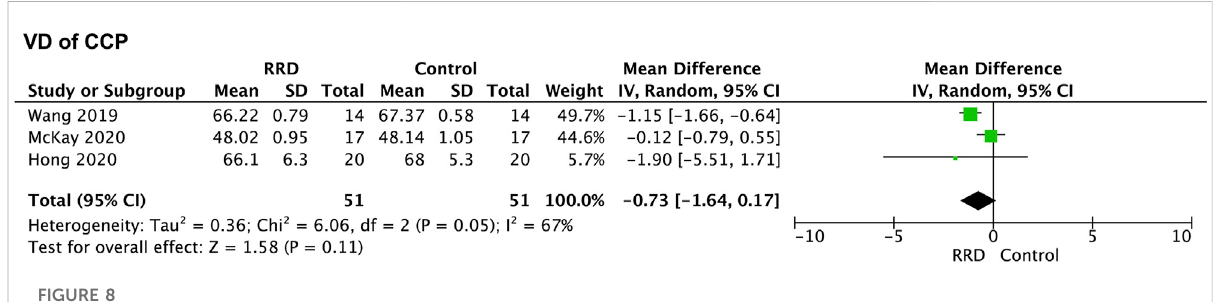
FIGURE 8 Forest plots of changes in VD of the choriocpillaris in eyes with macula-off RRD. VD, vascular density; RRD, rhegmatogenous retinal